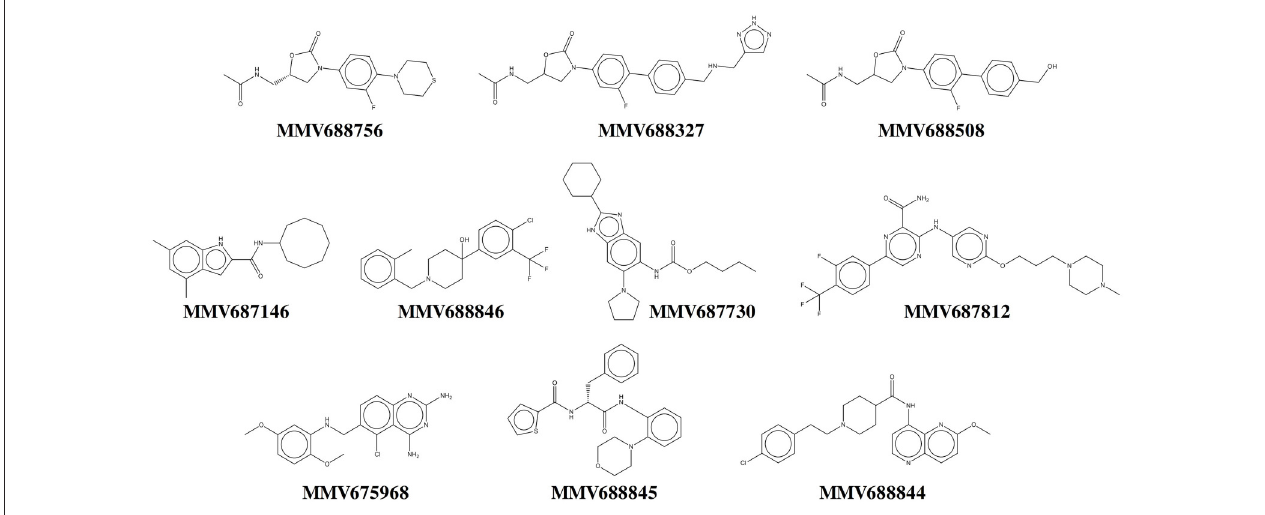
FIGURE 3 | Chemical structures of top NTM hits identified in the Pathogen Box screen.